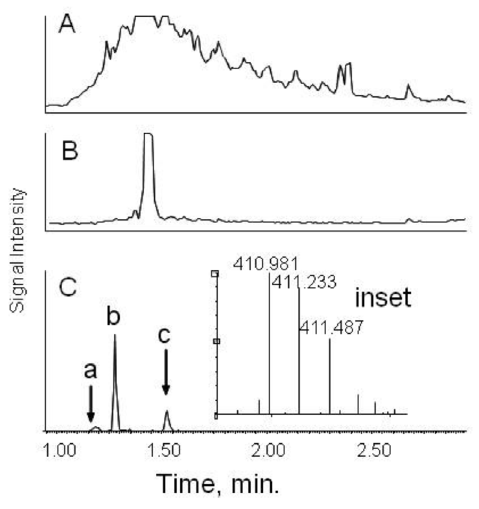
Figure 1. UPLC separation of BALF fluid. Panel A. Total ion current for a typical sample from an individual with BOS. Panel B. Total ion current for a control subject who did not develop BOS within at least 100 months. The intensity has been adjusted to the same maximum as Panel A. The large peak at 1.48 minutes corresponded to lidocaine. Panel C. Extracted ion current for the + 4 charge state of a component at m/z=410.98. Only peak b represented a monoisotopic ion. Peaks a and c were isotopes of other compounds.